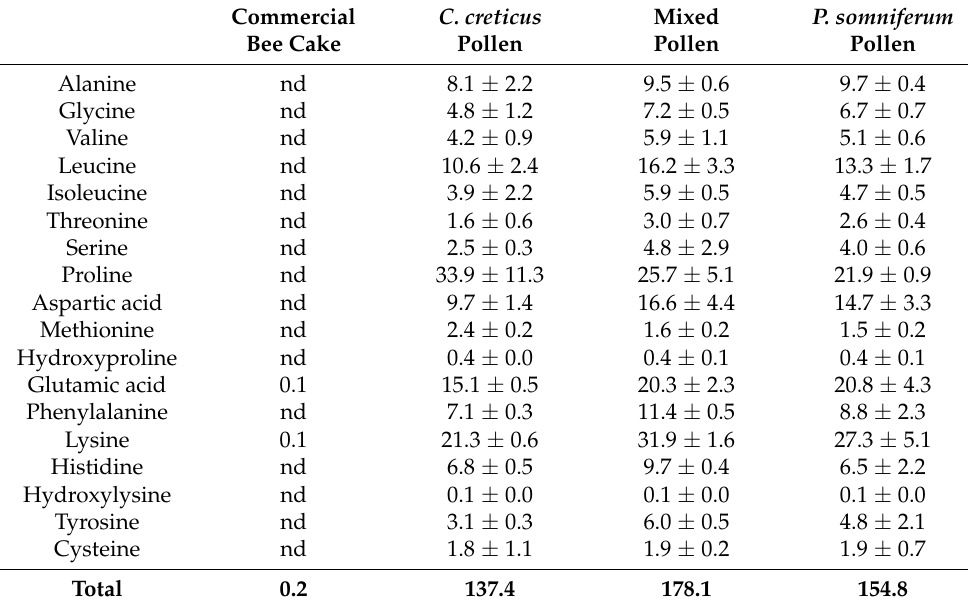
Table 2. Amino acid content of feeds in experimental groups